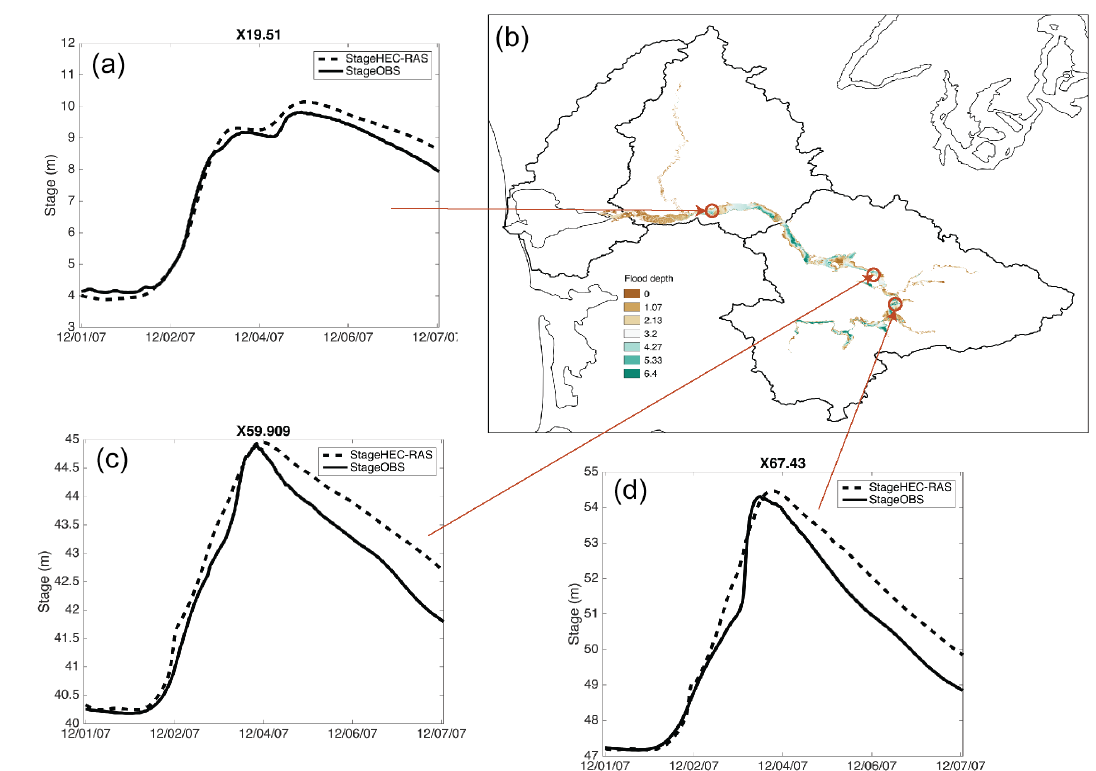
Figure 6. (a, c, d) USGS observed (solid) and simulated (dashed) stage for three cross sections of the Chehalis River main stem as represented by HEC-RAS. (b) . Flood extent and depth map as simulated by HEC-RAS.